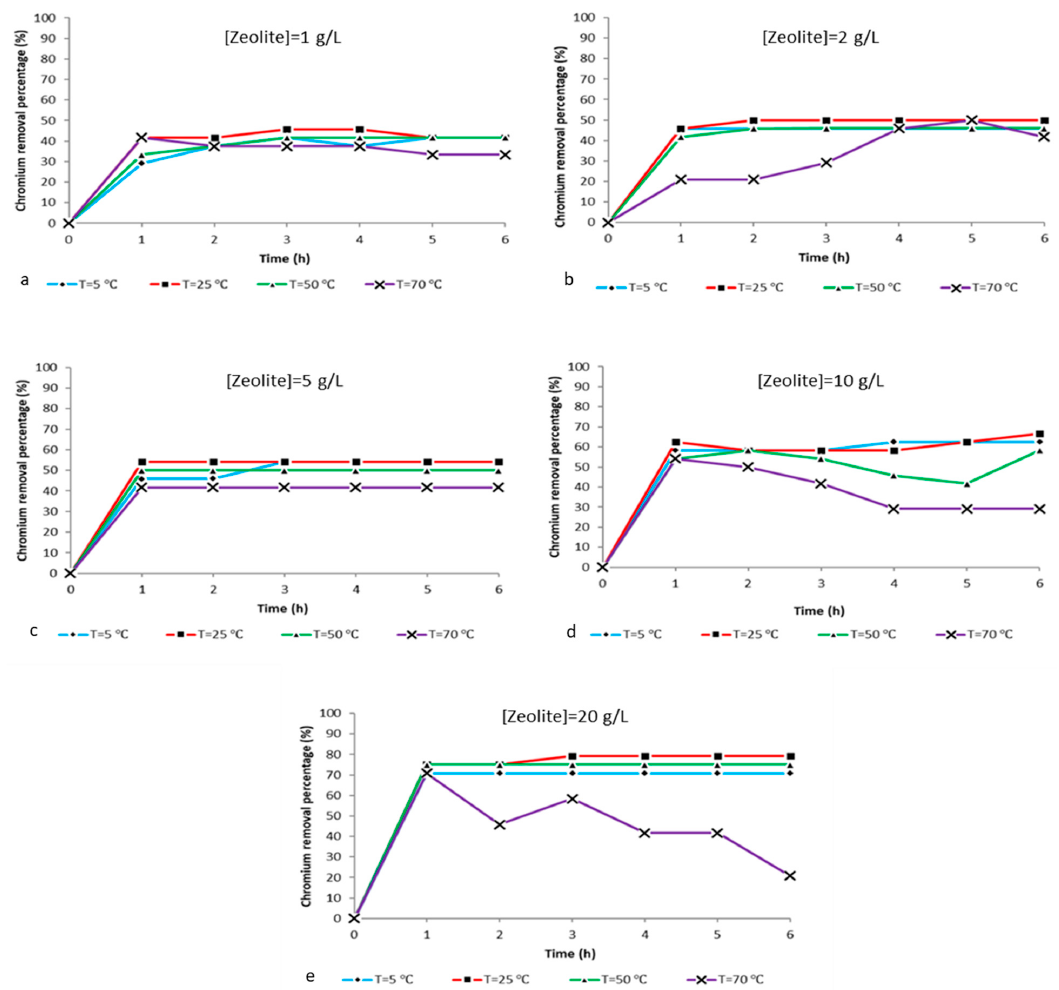
Figure 9. Chromium removal percentage vs time at different temperatures (5 °C, 25 °C, 50 °C and 70 °C) and pH 5.5 for the ratios ( a ) 2:1 g/L, ( b ) 2:2 g/L, ( c ) 2:5 g/L, ( d ) 2:10 g/L and ( e ) 2:20 g/L potassium dichromate:zeolite X.